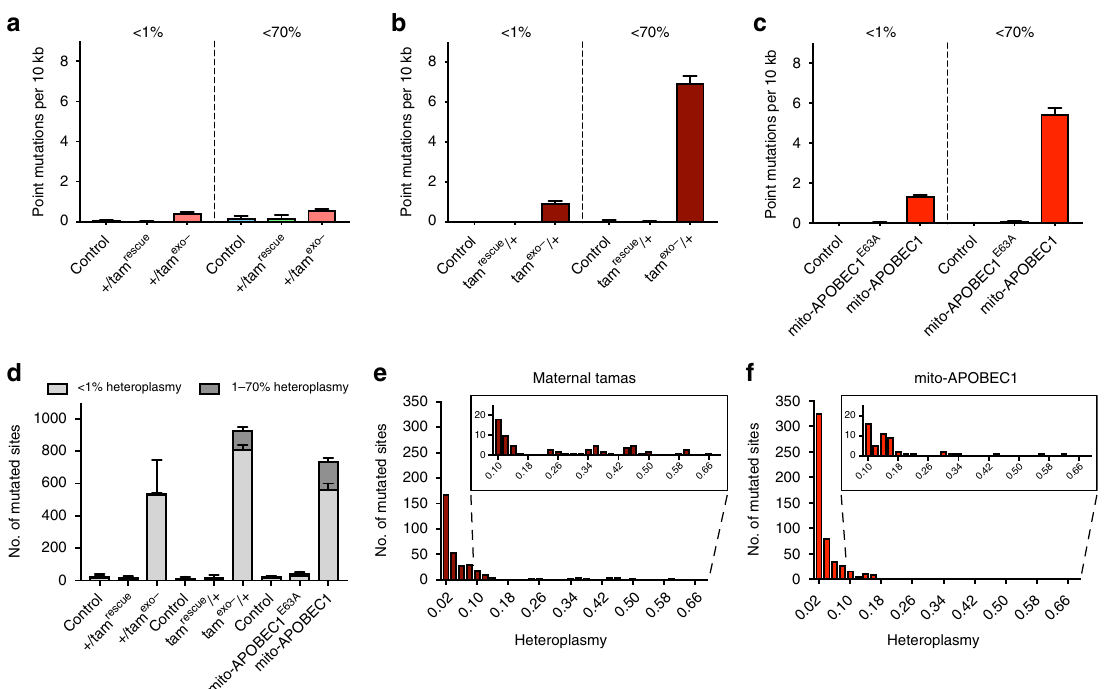
Fig. 6 High levels of heteroplasmy occurs in maternal tam exo − and mito-APOBEC1 . Point mutation load of low heteroplasmy events (<1%) compared to all observed mutations (<70% heteroplasmy) found in 10-day-old a paternally inherited tam exo- , b maternally inherited tam exo − and c mito-APOBEC1 mutator fl ies and respective controls. Mutation loads for total mutations (<70% heteroplasmy) are the same as shown in Fig. 1a, and reproduced here for comparison. d Number of sites that show low (<1%) or moderate (1 – 70%) heteroplasmy. Charts show mean ± SD, n = 3 animals. e , f Frequency distribution of >1% heteroplasmic sites in e maternally inherited tam exo − and f mito-APOBEC1 fl ies. Each chart shows the frequency distribution of the number of mutated sites with heteroplasmy bin width = 0.02, centred as indicated. Sites with heteroplasmy spanning 9 to 69% are zoomed. Source data are provided as a Source Data fi